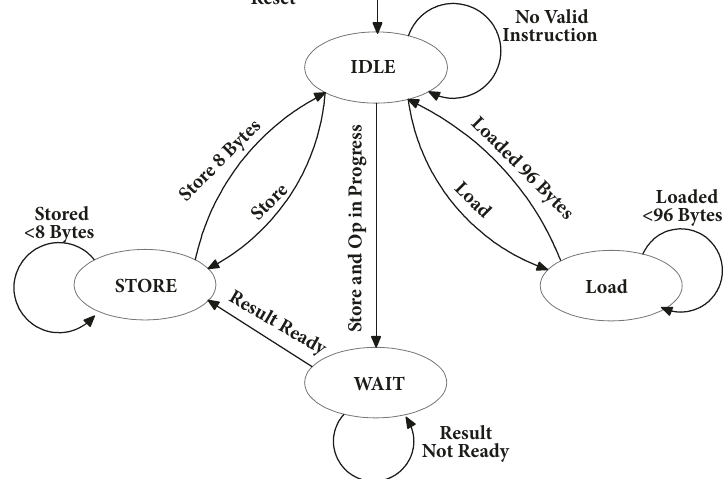
Figure 6: The data flow of the main state